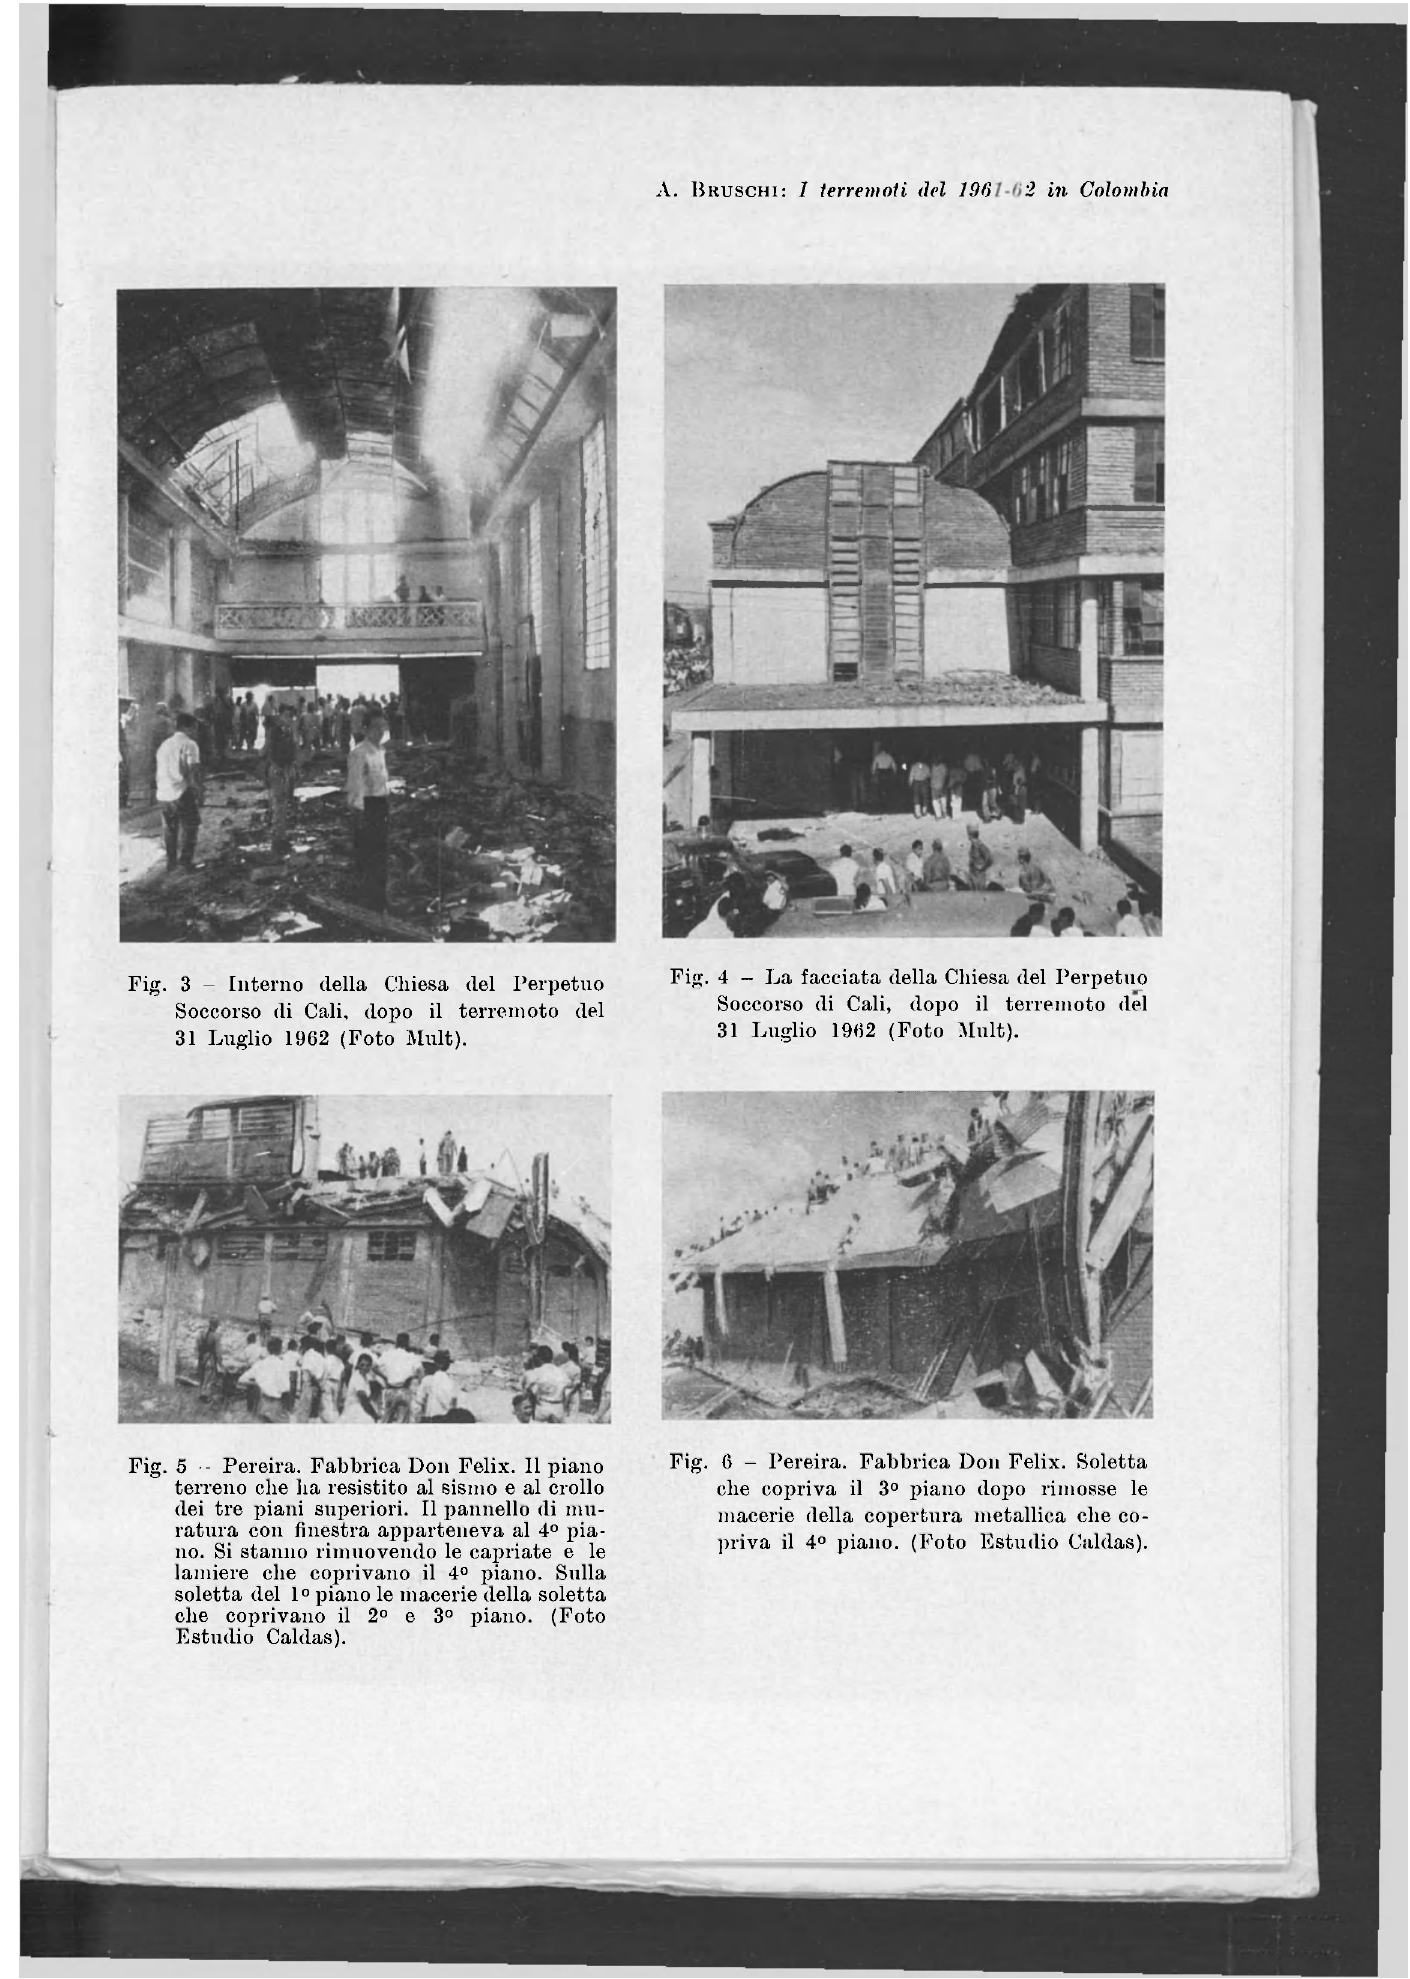
Fig. 5 •- Pereira. Fabbrica Don Felix. 11 piano terreno che ha resistito al sismo e al crollo dei tre piani superiori. Il pannello di mu- ratura con finestra apparteneva al 4° pia- no. Si stanno rimuovendo le capriate e le lamiere che coprivano il 4° piano. Sulla soletta del 1° piano le macerie della soletta che coprivano il 2° e 3° piano. (Foto Estudio Caldas).